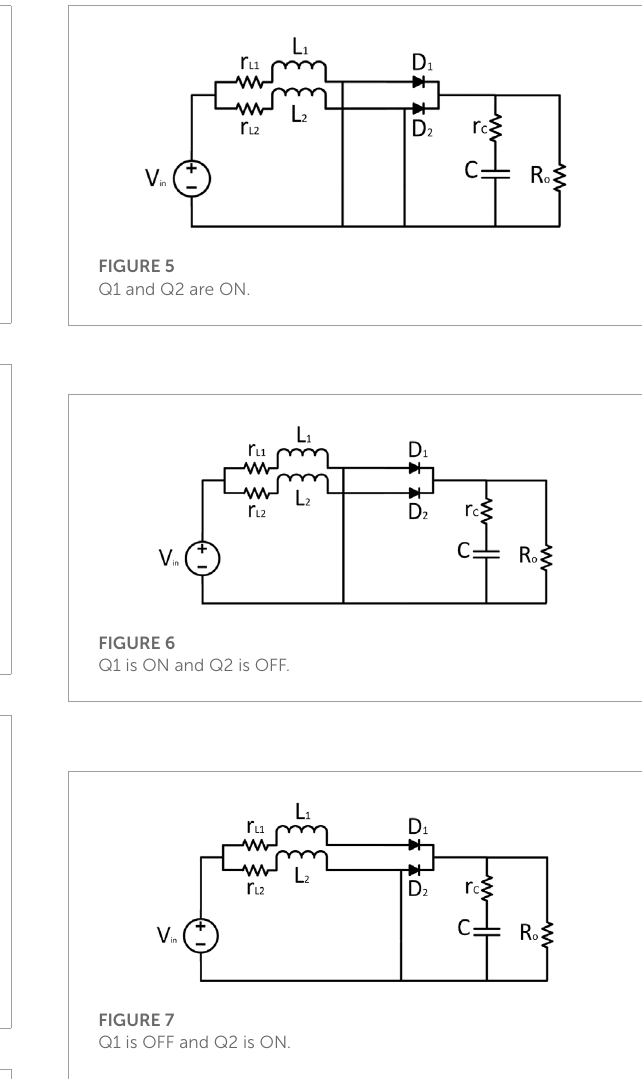
FIGURE 7 Q1 is OFF and Q2 is